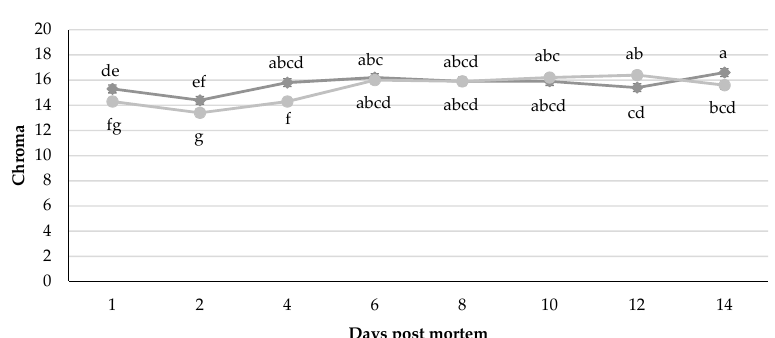
Figure 5. Effect of sex and ageing (days post-mortem ) on the chroma values of the surface color of impala longissimus thoracis et lumborum meat from females and males. a–g Means with different superscripts differ from one another ( p ≤ 0.05). Error bars represent the standard error of the means. No interactions were recorded between sex and ageing period for the b* values or hue angles of impala LTL muscles, and there were no differences between sexes (Table 1). However, the post- mortem ageing period had a significant influence on the b* values of impala LTL meat. The lowest b* values were recorded on day 1 (7.6 ± 0.23), with a steady increase as the ageing period progressed until a plateau was reached at the highest b* values from day 10 onwards (Table 1). The post-mortem ageing period also had an influence ( p < 0.001) on the hue angle, which was lowest on day 1, after which it fluctuated between day 2 to 8, where after it reached a plateau from day 10 until day 14. Female impala meat had higher ( p < 0.001) shear force values than males at day 1, 2, and 4, while no differences were recorded between the sexes from day 6 to day 14 (Figure 6). All muscles, regardless of sex, showed a gradual decline in shear force values until day 8, after which a plateau was reached until the end of the ageing period at day 14.